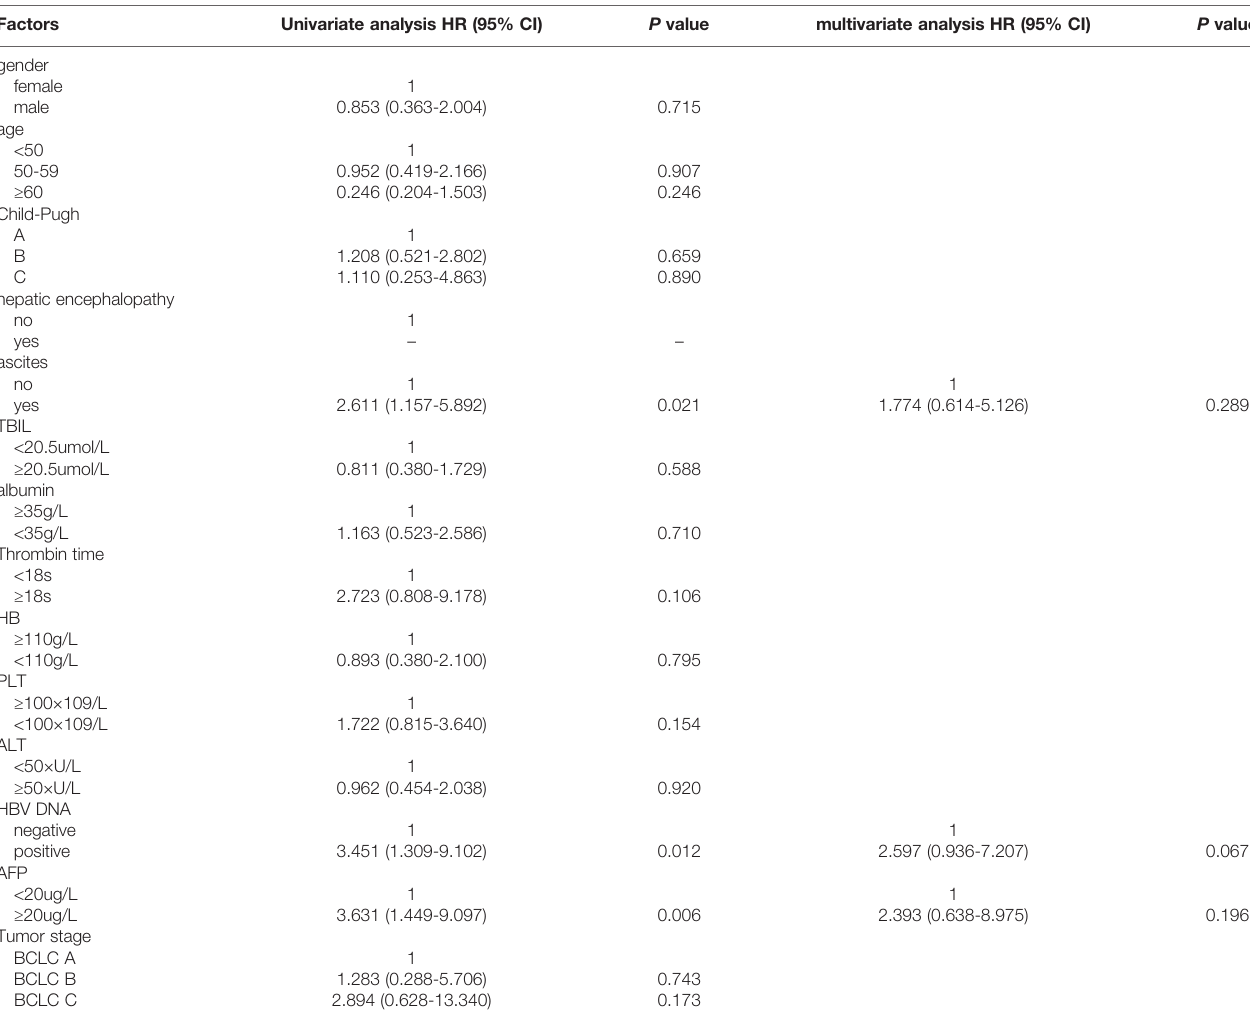
TABLE 2 | Subgroup analysis of patients with OS.